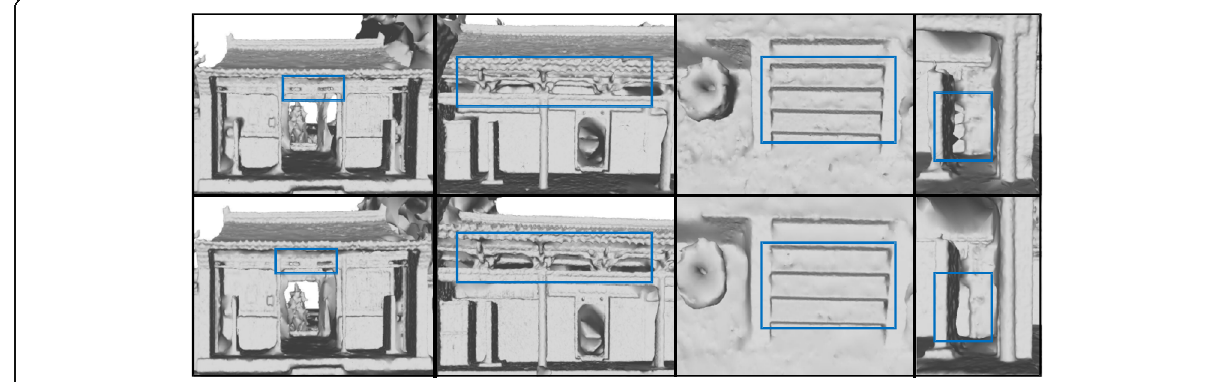
Fig. 5 Comparison between N max = 1.3 × 10 7 and N max = 6.0 × 10 6 . The first row is the results for N max = 6.0 × 10 6 , and the second is for N max = 1.3 × 10 7 . When N max = 6.0 × 10 6 , the quality of merged surface is reduced to some extent, compared with the results obtained when N max = 1.3 × 10 7 is used in some areas, which reflects the balance between memory consumption and reconstruction